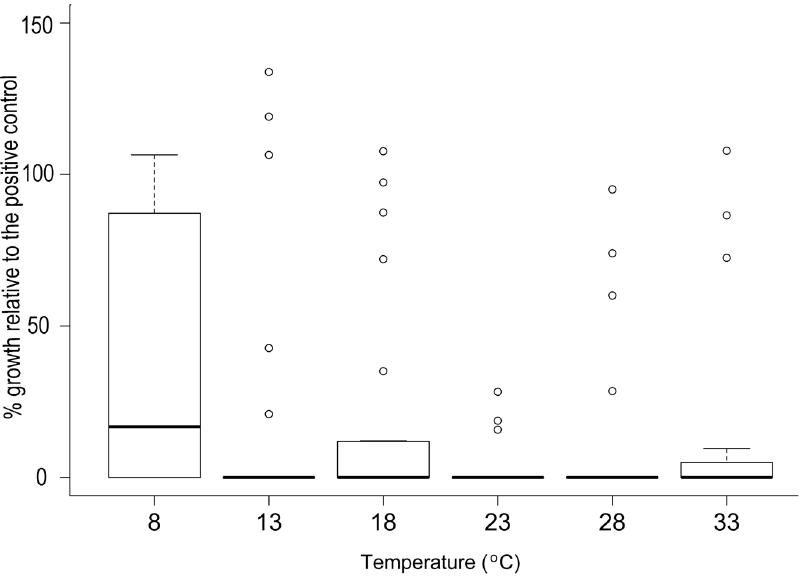
Figure 4. Percent Bd growth relative to the positive control ( Bd -alone; 100%) in bacterial cell-free supernatants from 24 bacteria identified in initial screening at 23 6 C as strongly inhibitory to Bd and grown in each of six temperature conditions. A value of 0 indicates complete inhibition of Bd growth, and a value of 100% indicates growth equivalent to that of the positive control (for details see above and [30] ). Boxes show the interquartile range (IQR) and the median. Brackets are the most extreme values to 1.5X the IQR, and individual points are those beyond this span. Where boxes are not visible, IQR was near zero.